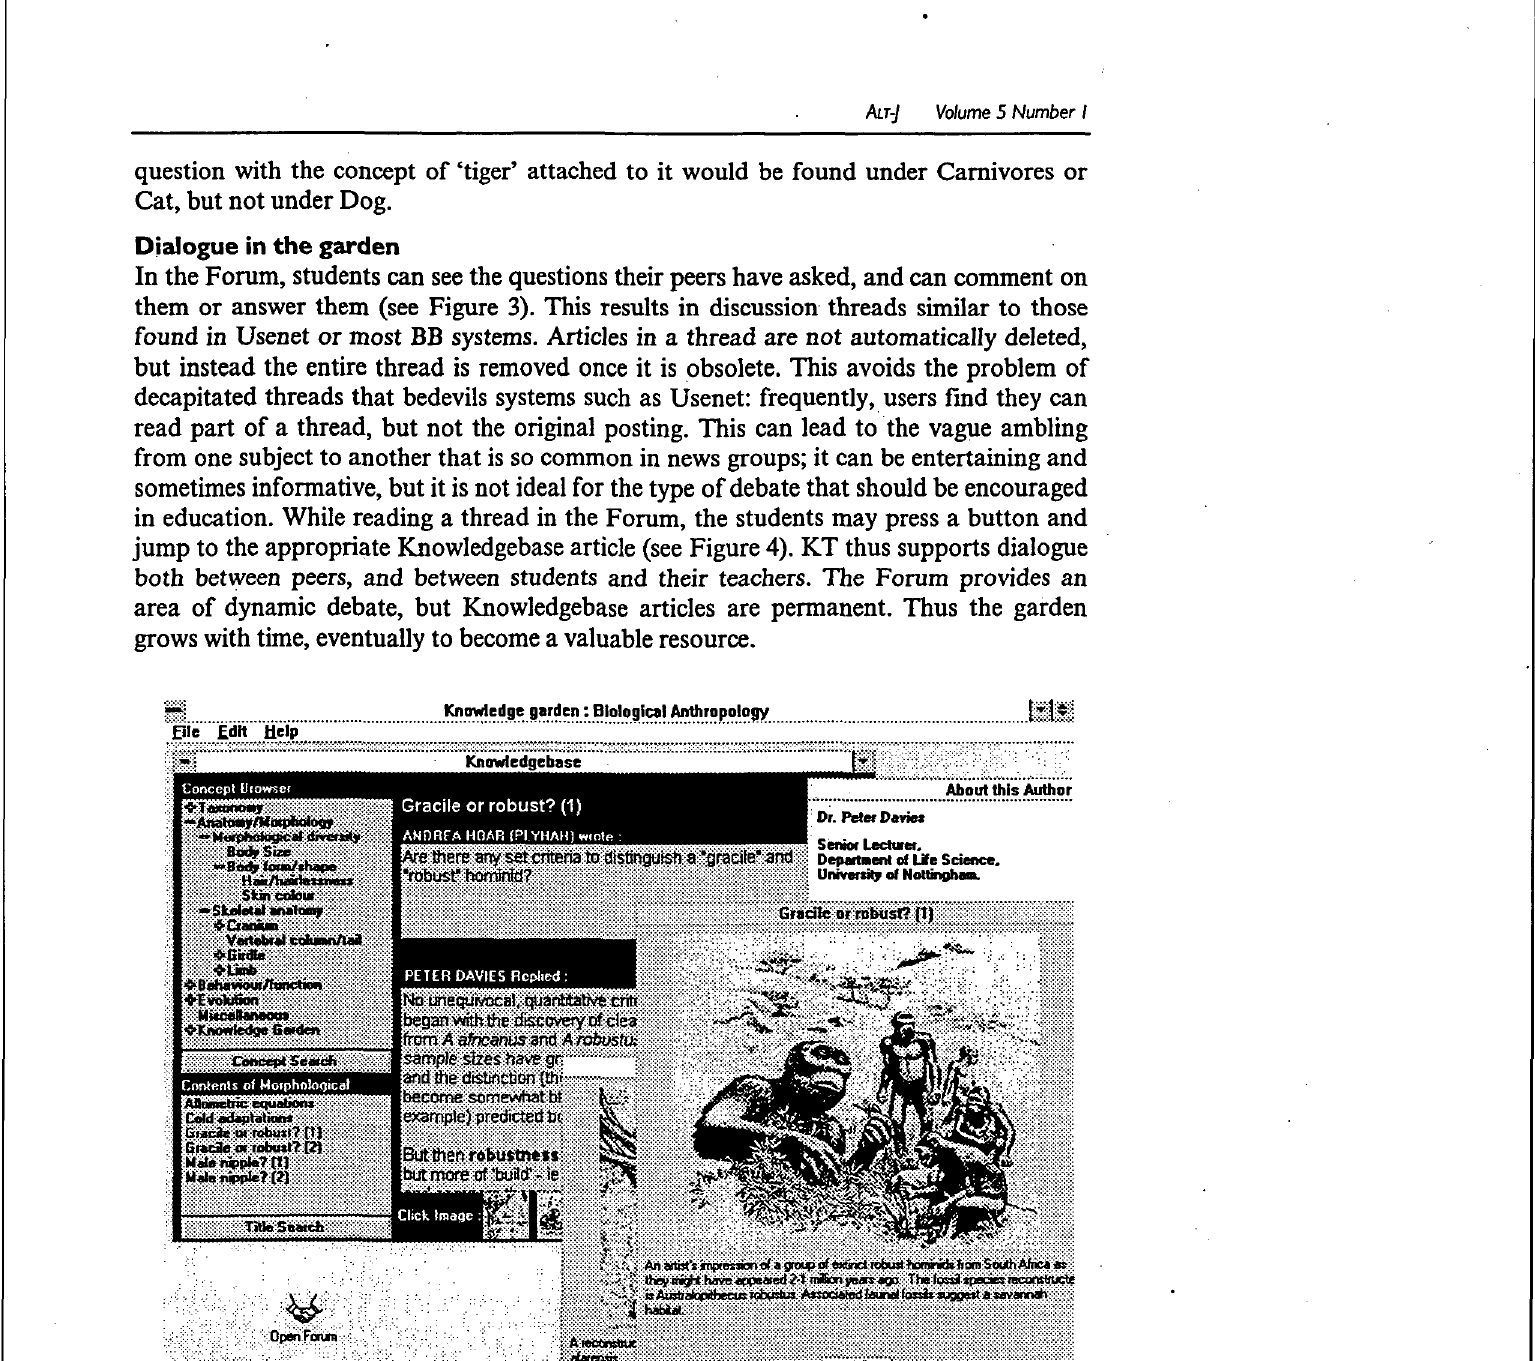
figure 3: Part of the Knowledgebase from a Biological Anthropology knowledge garden The Knowledge Tree in